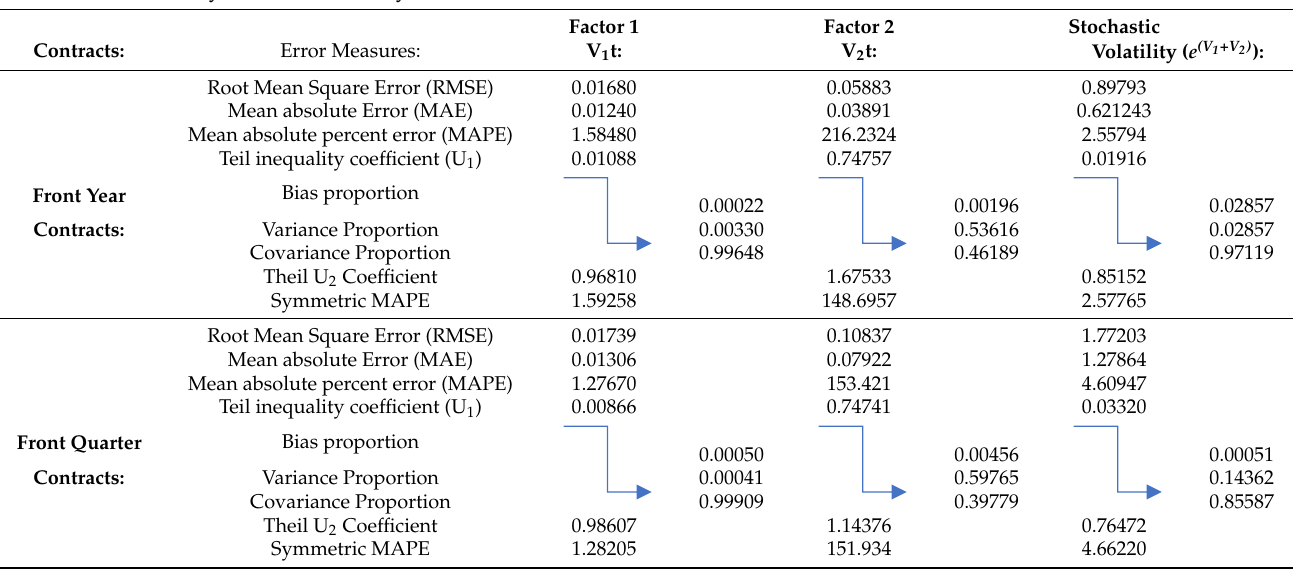
Table 4. Nasdaq OMX Front Quarter and Front Year Contracts Static Forecast Evaluation Statistics 2020/21 .